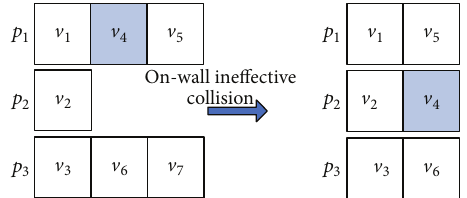
Figure 5: Illustration of the task-to-computing-node mapping for on-wall ineffective